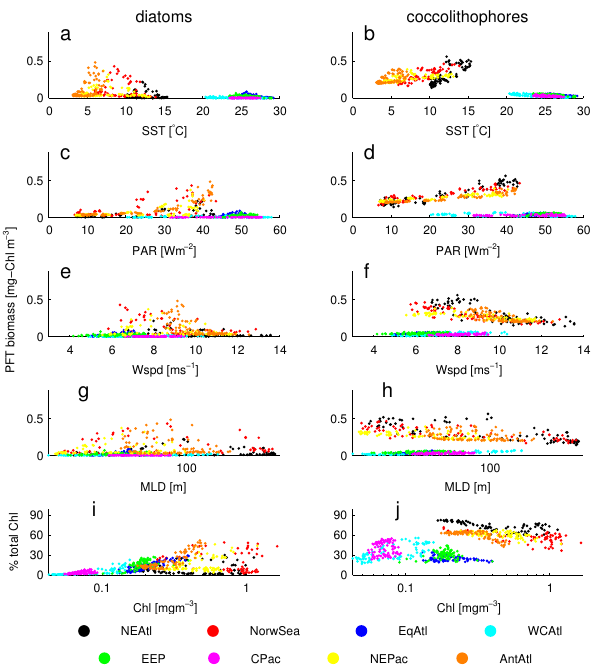
Fig. 4. Scatter plots showing the emerging relationship between PhytoANN cyanobacteria (left column) and chlorophyte (right col- umn) biomass [mgChlm − 3 ] (a–h) or % of total Chl (i, j) vs. in- dividual ecological indicators color coded according to domain of origin. On the x axis from top to bottom: SST, PAR, Wspd, MLD and Chl. All data points come from exploratory analysis only, and thus they are box average and monthly average estimates from Oc- tober 1997 to December